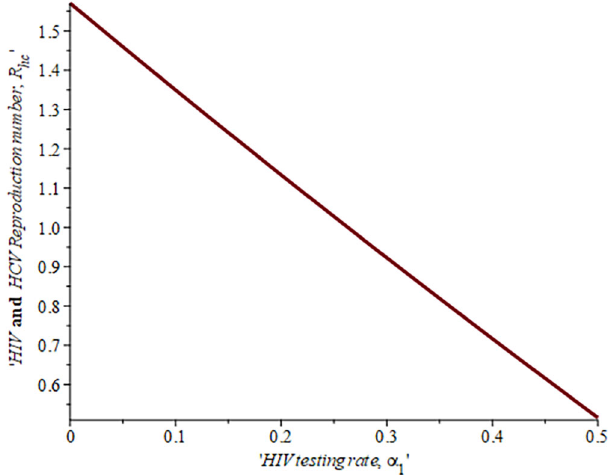
Figure 14. Impact of HIV testing rate on HIV-HCV co-infection reproduction